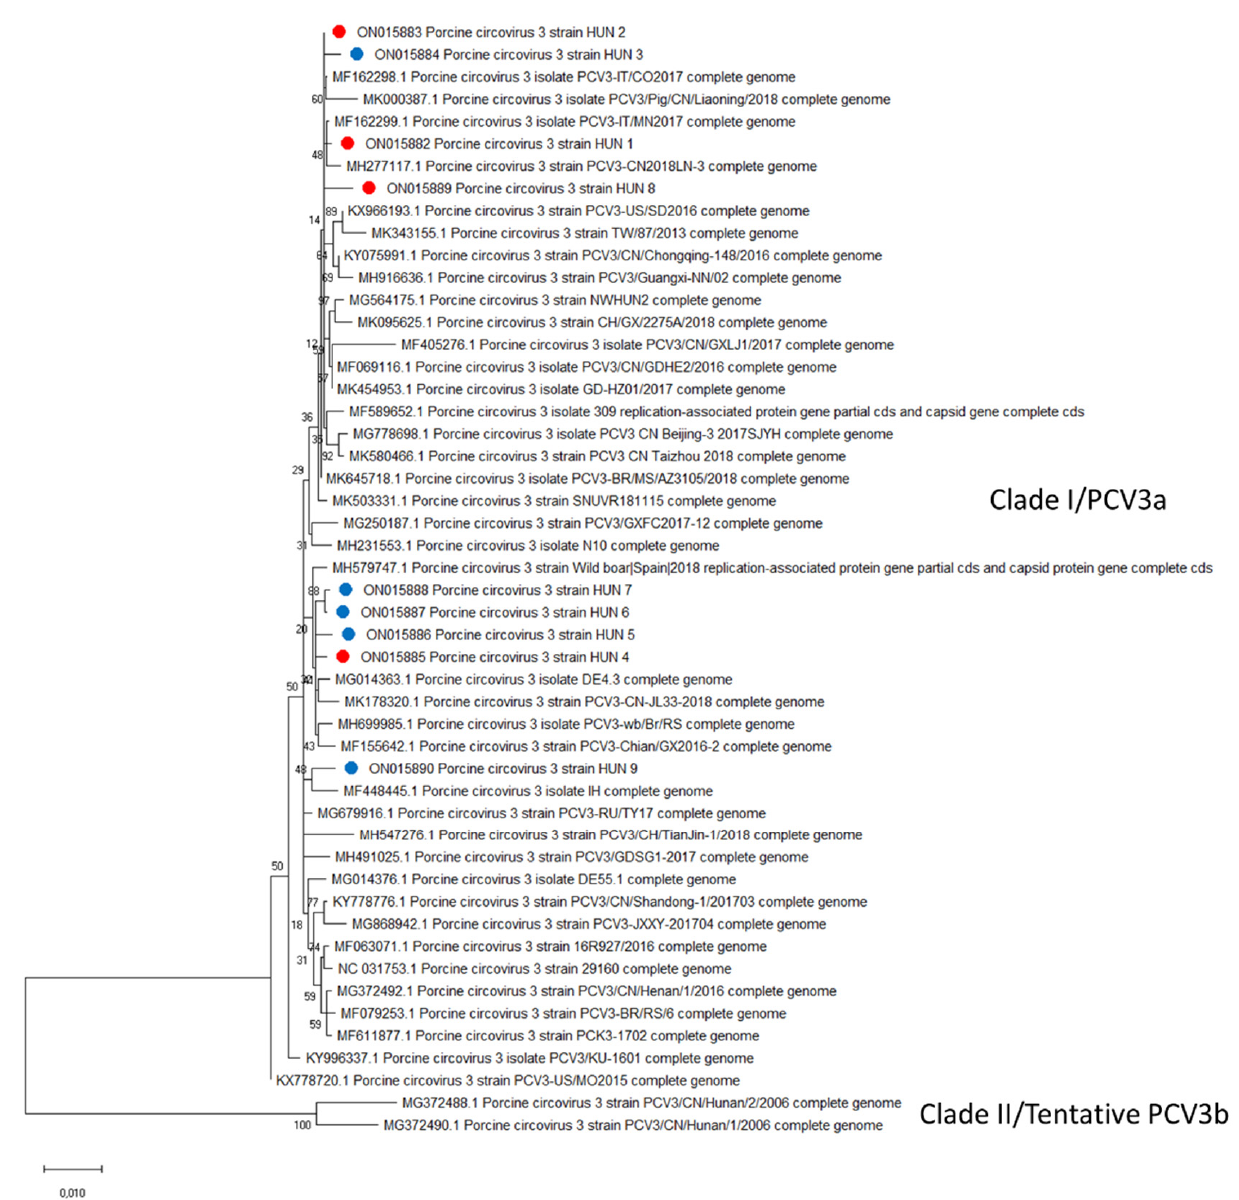
Figure 6. Phylogenetic analysis of PCV3 full-genome sequences. The phylogenetic tree was con- structed using MEGAX [35] with the Maximum Likelihood method performing 1000 replicates of bootstrap analysis. A total of 41 reference sequences listed by Franzo et al. [33] were aligned against the sequences detected in this study. The sequences obtained from serum samples collected on the examined farms are presented by red dots. The blue dots mark the sequences obtained from PCV3-positive clinical cases.